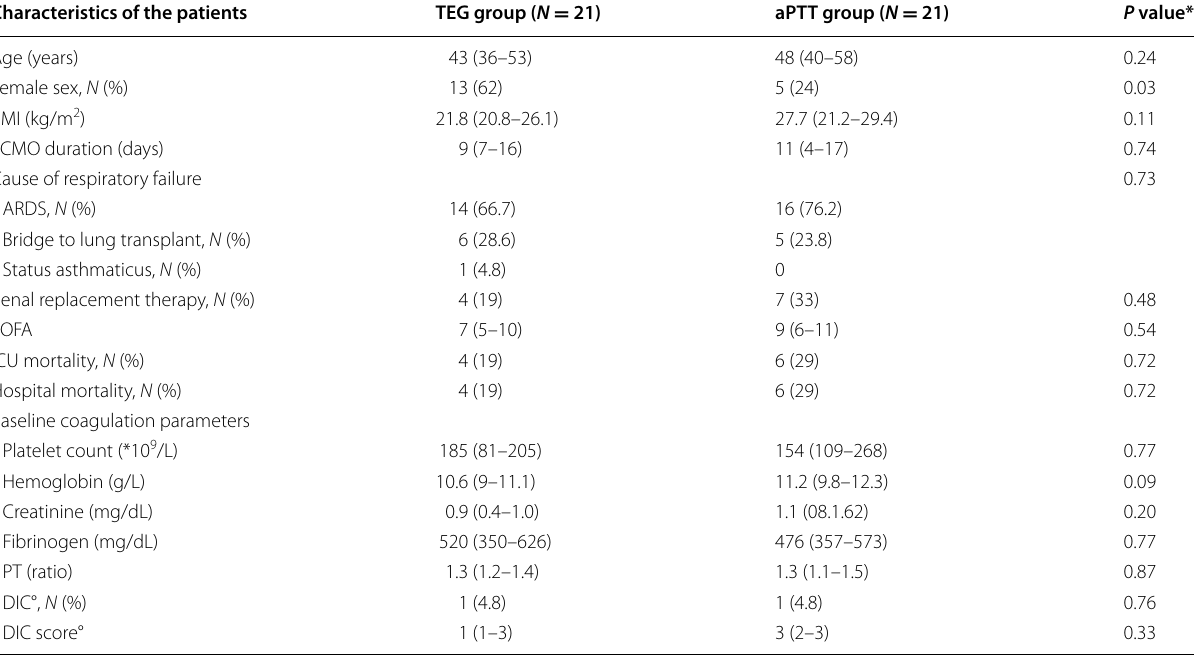
Table 1 Characteristics of the patients and baseline coagulation